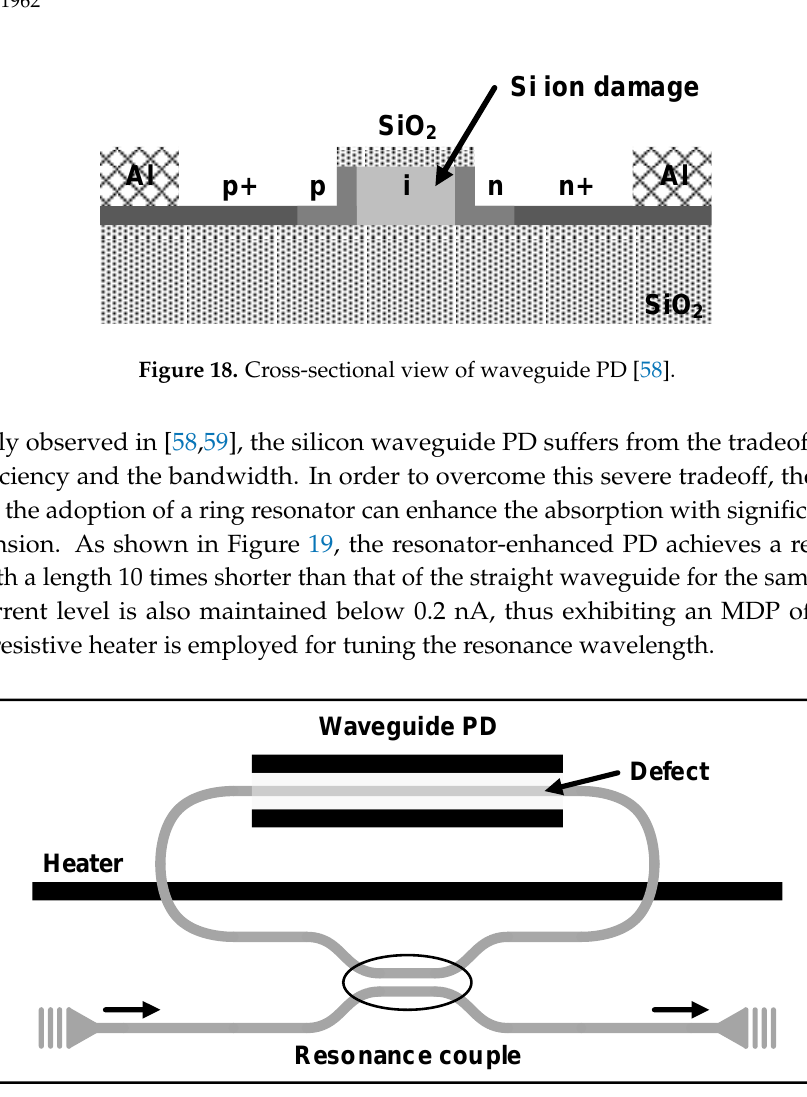
Figure 19. Schematic view of silicon resonator-enhanced PD [60].